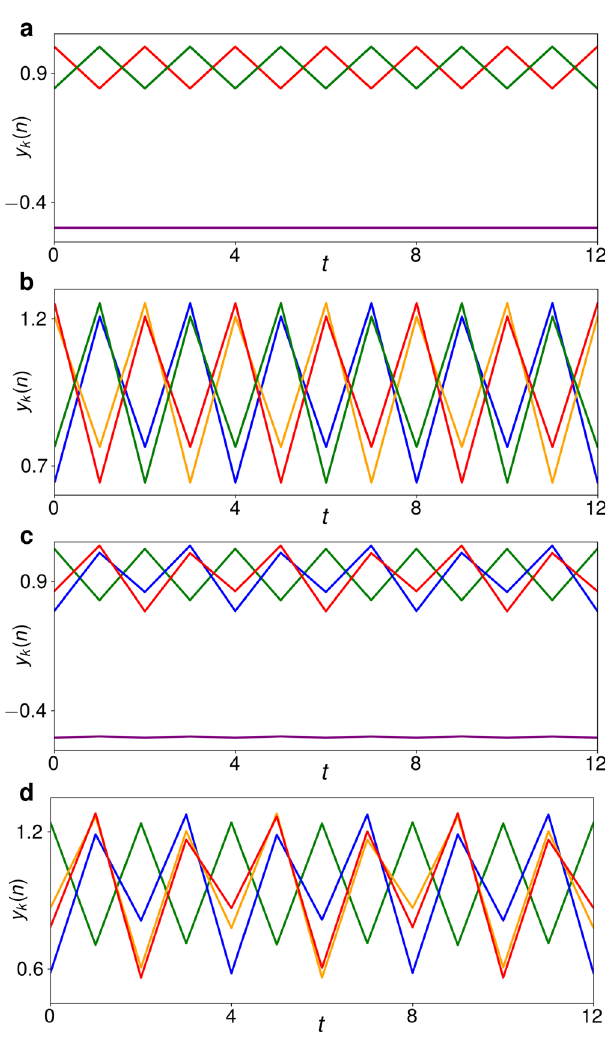
Fig. 7 Trajectories of time-discrete maps. a 8 − 4 − 4 solution for N = 16, α = 0.8 and β = 0.15, wherein the clusters of 4 (green and red, respectively) are period-2 and the cluster of 8 (purple) is constant. b 8 − (4 × 2) solution emerging in a period-doubling of the solution in a , with the cluster of 8 not shown for better resolution. α = 0.86. Here, each color marks the trajectory of a cluster of two. c 64 − 33 − 16 − 15 period-4 solution for N = 128, α = 0.86 and β = 0.15. Cluster trajectories: 64 purple, 33 green, 16 blue, 15 red. d 64 − 33 − 16 − 8 − 7 period-8 solution emerging in a period-doubling of the solution in c , with the cluster of 64 not shown. α = 0.87. The cluster of 15 has split into smaller clusters of 8 (red) and 7